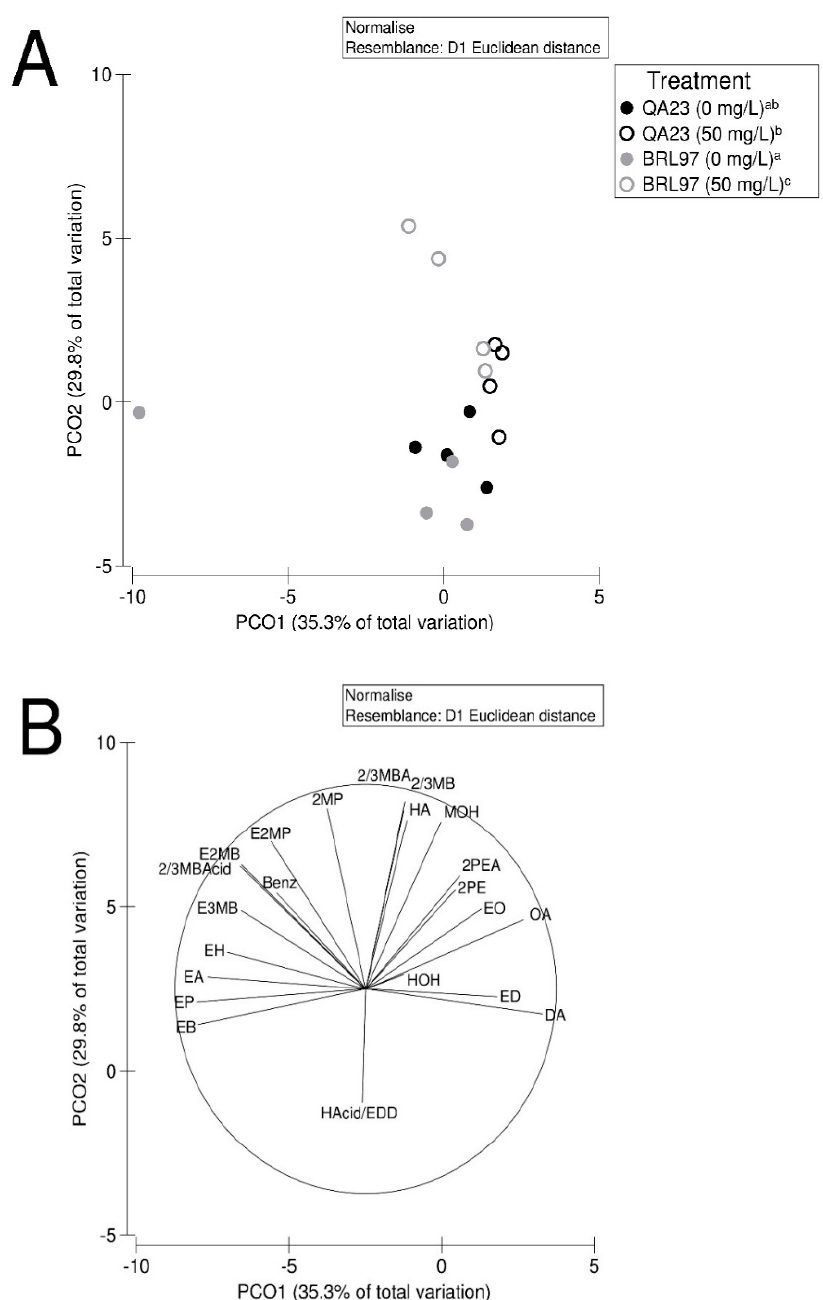
Figure 6. Principal coordinate analysis (PCoA) visualizing the production of volatile secondary metabolites by different yeast strains in controlled pinot gris fermentations containing either 0 mg/L or 50 mg/L SO 2 ( n = 4 per treatment). Plots depict ( A ) the individual factors map and ( B ) the variable factors map showing secondary metabolites as vectors. On the individual factors map, each point represents the entire volatile secondary metabolite composition of a single wine sample. Points that are closer together contain more similar volatile profiles than points that are further apart. On the variable factors map, the length of the variable vector reflects that variable’s relative contribution in producing this ordination. Variable vectors that point towards a sample are positively correlated with that sample, and those that point away from a sample are negatively correlated. Variable vectors that appear at a ~90° angle are not correlated with each other, while those that appear at <0° and >90° angles are positively and negatively correlated with each other, respectively.